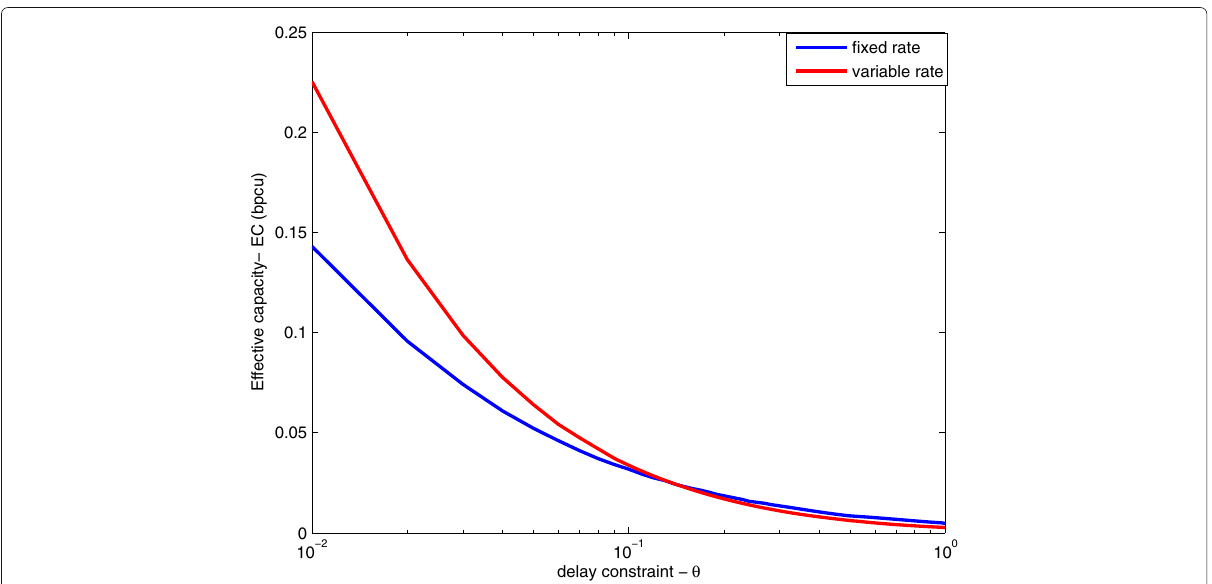
Fig. 11 Fixed rate. Comparison between fixed-rate transmission and variable rate for different values of delay constraint θ where ρ = 1 and T f =